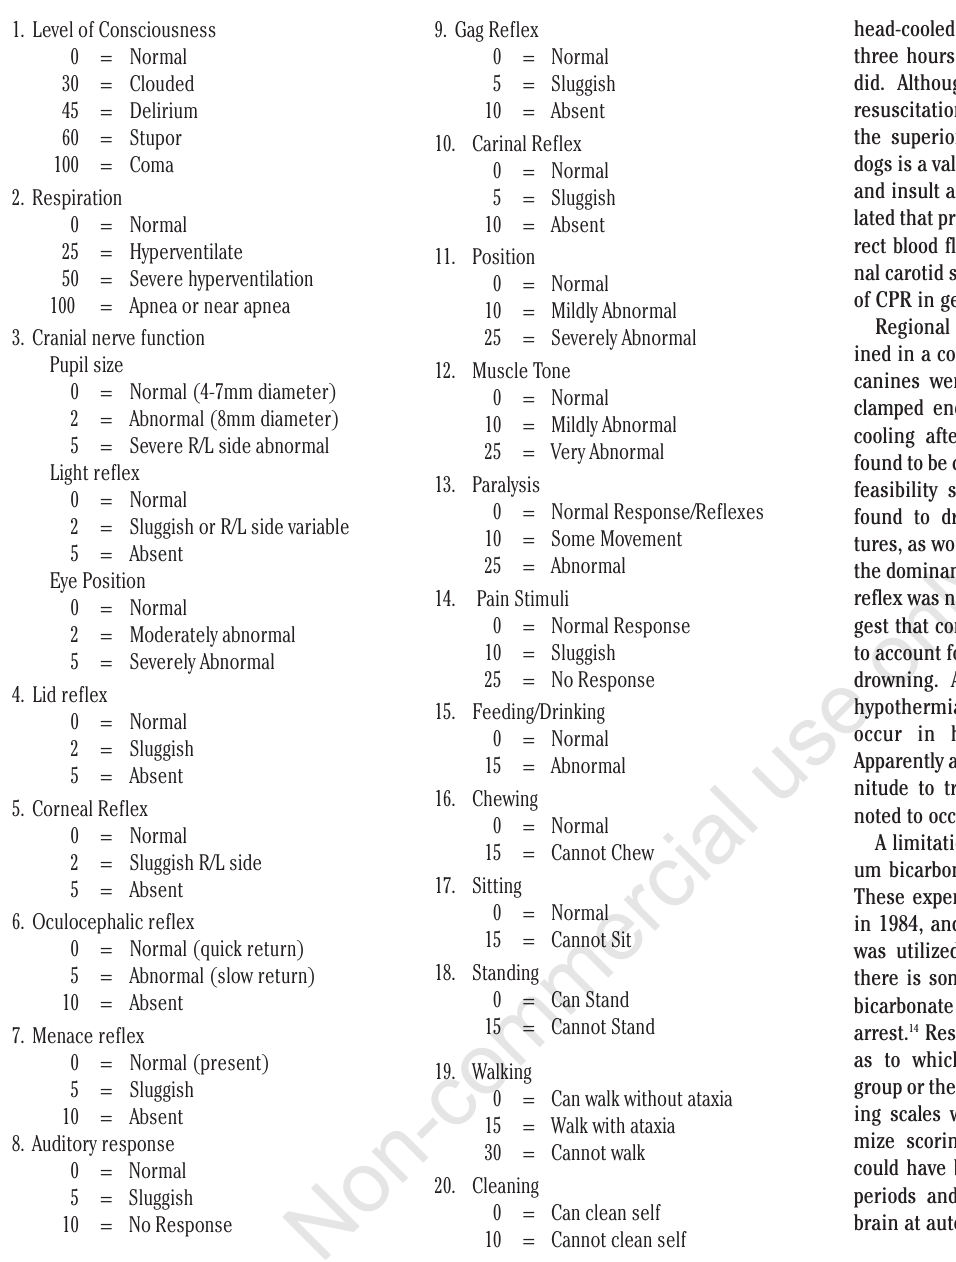
Figure 2. Canine neurological deficit